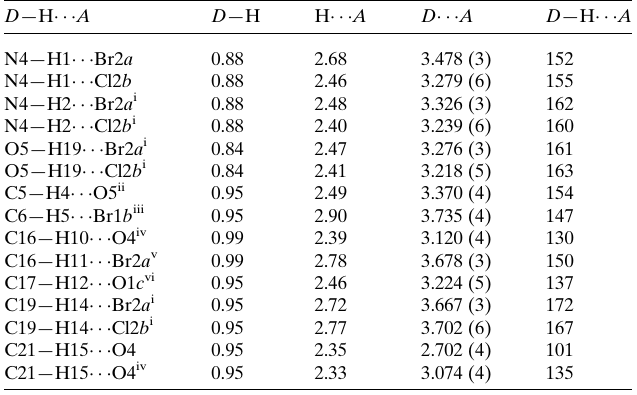
Table 1 Hydrogen-bond geometry (A˚ , (cid:5) ).